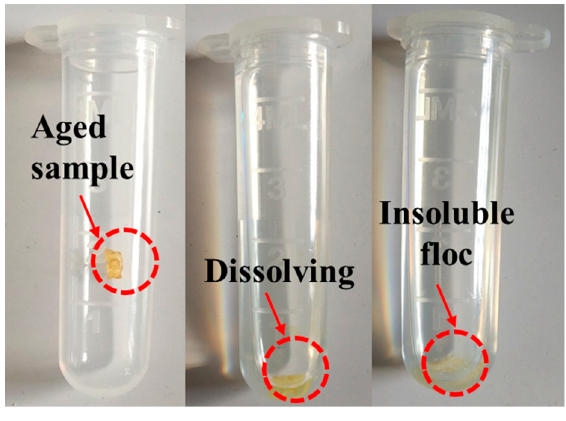
Figure 5. Insoluble yellow flocs.